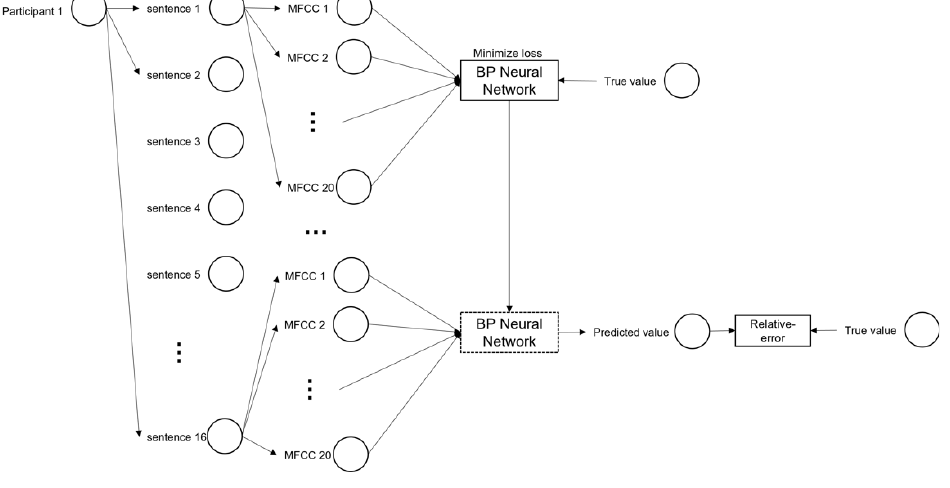
Figure 5. The G raph for D ata V isualization. Figure 5. The Graph for Data